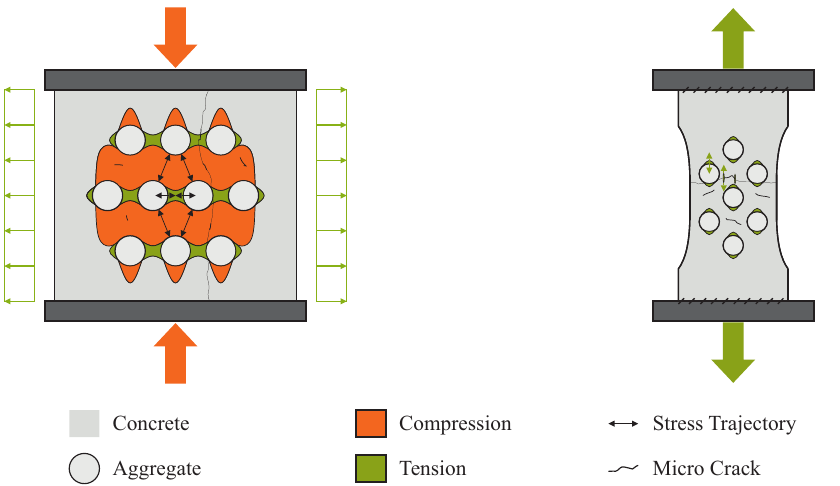
Figure 2. Uniaxial loading of normal concrete specimens, where the cement paste’s Young’s modulus is lower in comparison to the aggregate’s Young’s modulus. The experimental setups for both compression ( left ), and tension ( right ), correspond to the experiments in Section 3. The compression case is shown with the assumption of no friction at the contact surface between press and specimen.